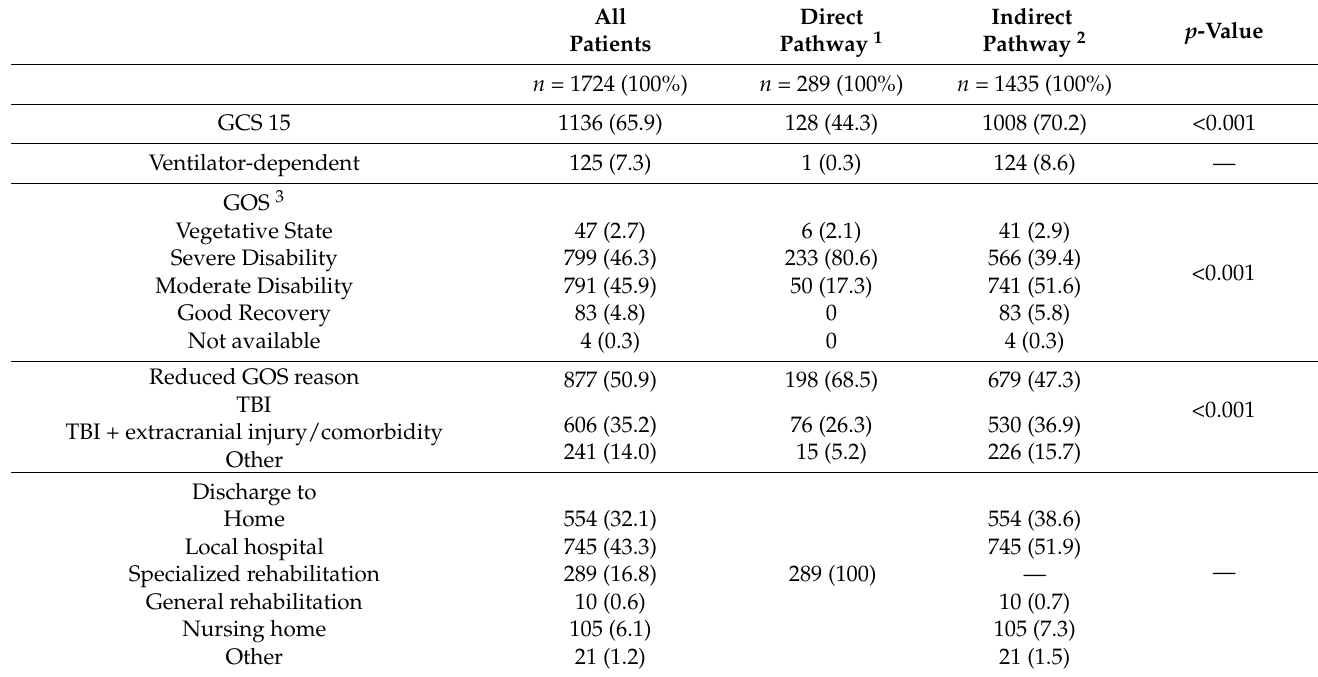
Table 3. Day of discharge from acute care units at OUH: functional level and destination. All